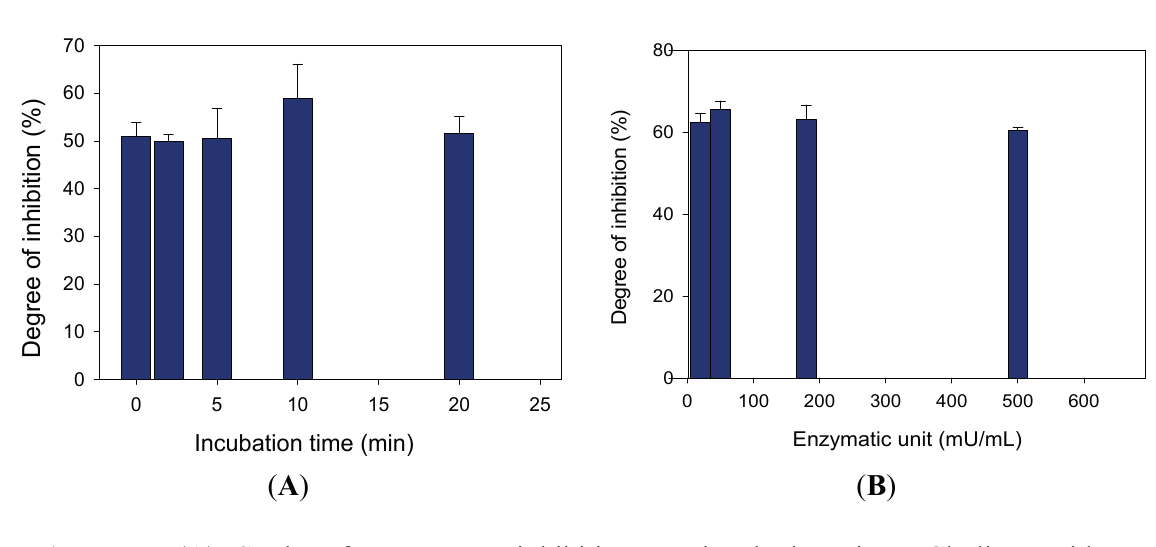
Figure 5. ( A ) Study of percentage inhibition vs . incubation time . Choline oxidase concentration: 180 mU/mL; choline concentration: 0.5 mM; bis(2-chloroethyl)amine concentration: 2.5 mM; phosphate buffer 0.05 M + 0.1 M KCl, pH 7.4; potential: − 50